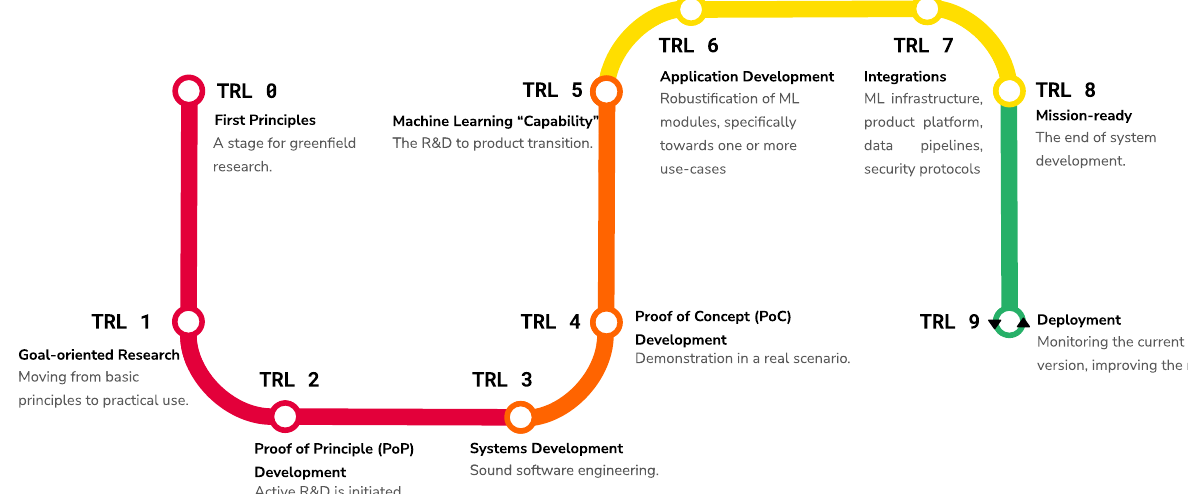
Fig. 1 | MLTRL spans research (red) through prototyping (orange), producti- zation (yellow), and deployment (green). Most ML work fl ows prescribe an iso- lated, linear process of data processing, training, testing, and serving a model 37 . Those work fl ows fail to de fi ne how ML development must iterate over that basic